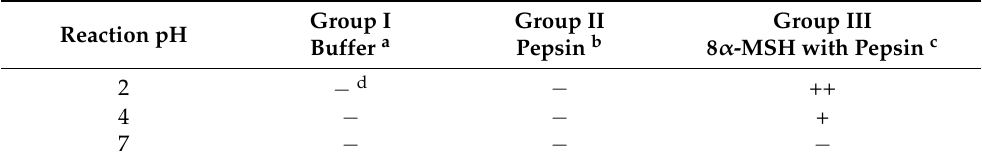
Table 4. Effect of pepsin cleavage of 8 α -MSH at different pH. Reaction pH